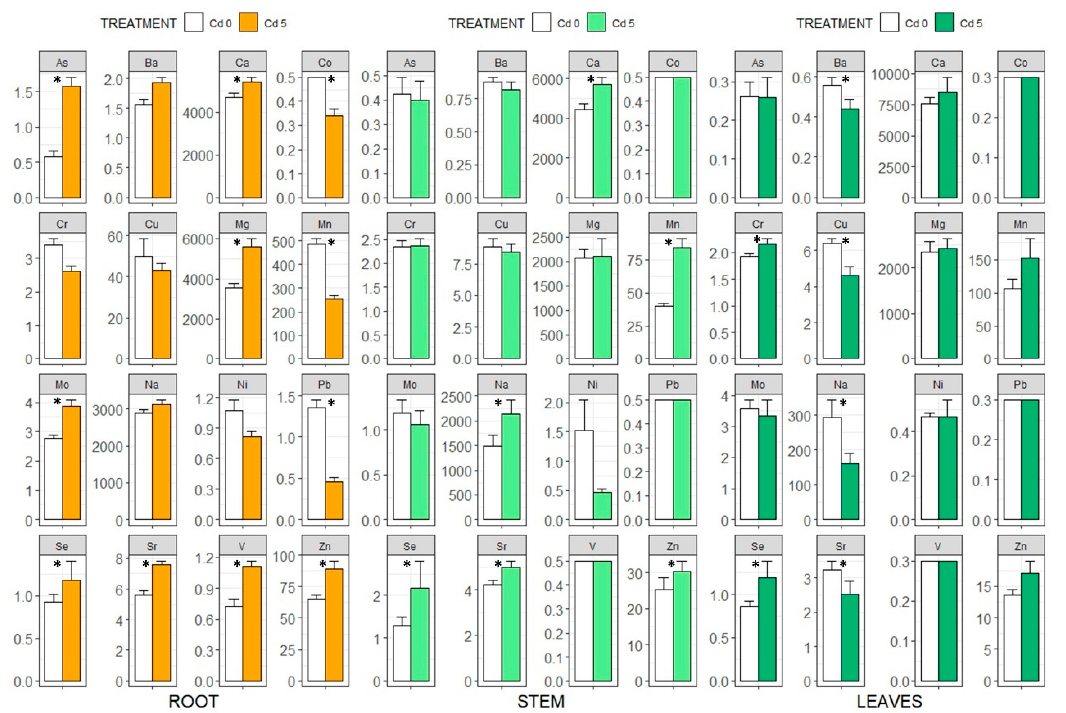
Figure 4. Effect of 5 μ M Cd on micronutrient contents in each eggplant organ: root, stem and leaves. Error bars represent the standard deviation (* = p ≤ 0.05).